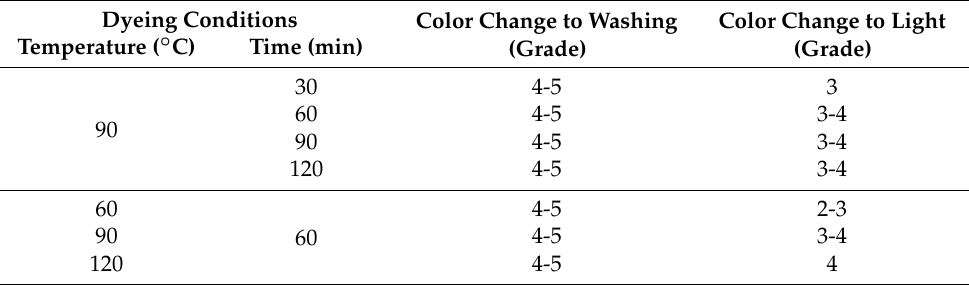
Table 2. Color fastness of wool fabrics dyed with spent coffee extract and mordanted with 1 wt % tannic acid aqueous solution.